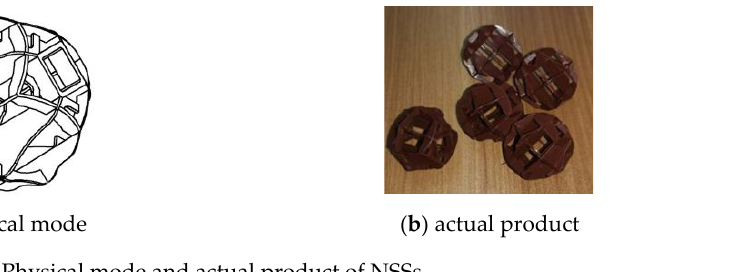
Figure 1. Physical mode and actual product of NSSs.